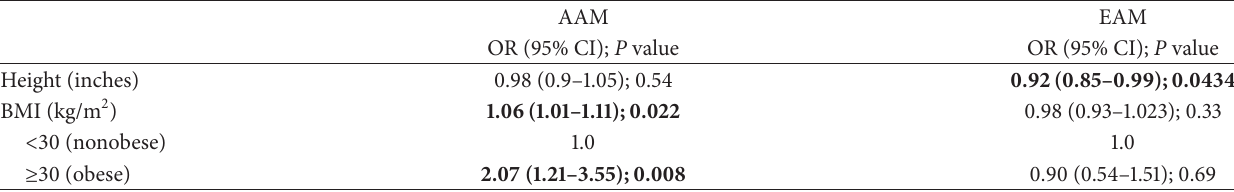
Table 3: Age-adjusted association between selected anthropometric variables and PCa in men stratifying by race and combined. AAM EAM OR (95% CI); P value OR (95% CI); P value